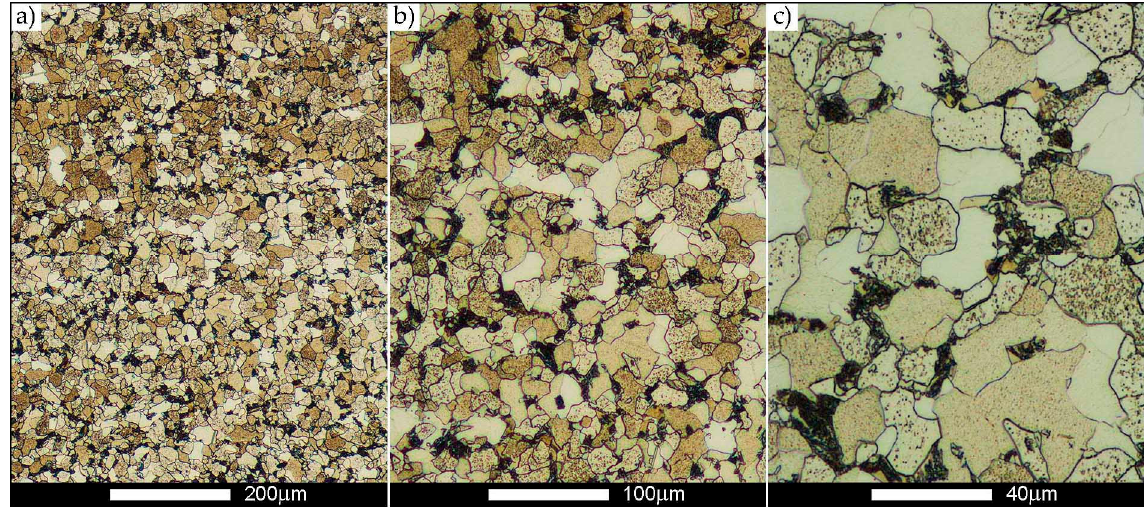
Figure 30. Welded joint microstructure of Hardox 450 steel in the normalised state with revealed grain boundaries of prior austenite—WM1 zone shown in Figure 2. ( a ) 100×; ( b ) 200×; ( c ) 500×.